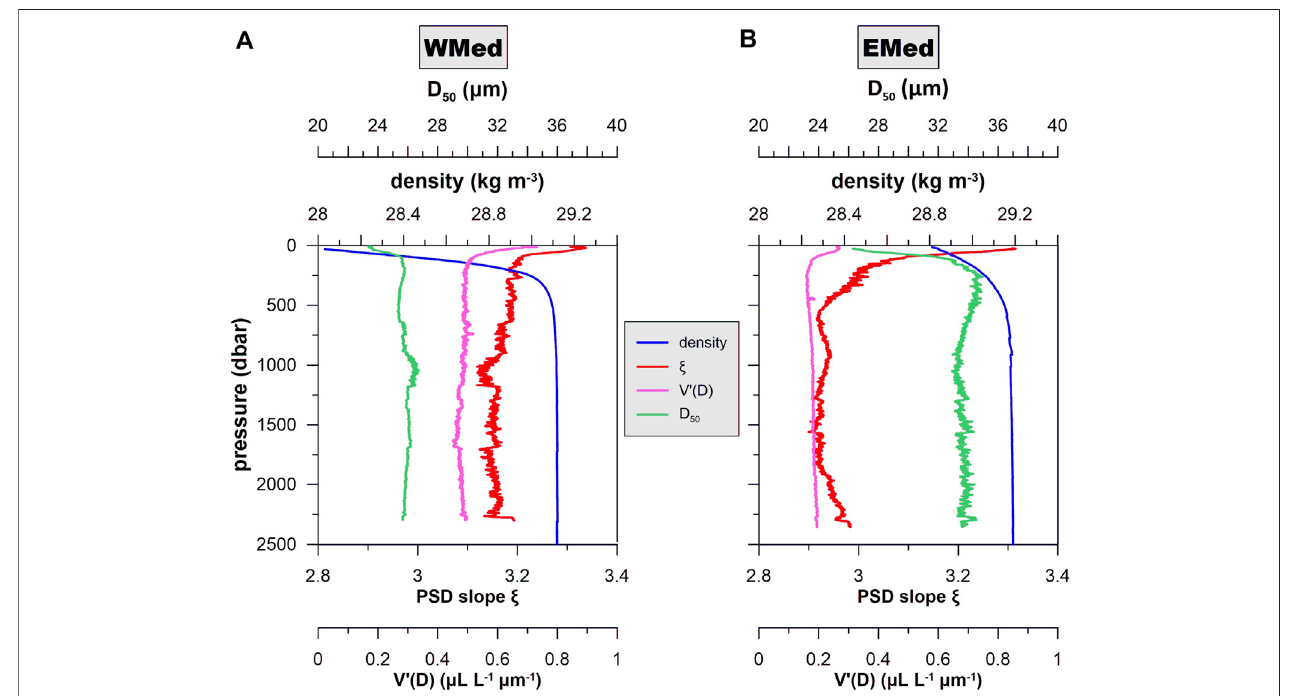
FIGURE 7 | Pro fi les of mean (smoothed by a 10-point moving average) density, V ’ (D), D 50 , and PSD slope ξ for the WMed (A) and EMed (B) . Differential particle volume V ’ (D) in the WMed is almost double in the WMed than in the EMed. Mean ξ in the WMed is overall higher than the EMed demonstrating the presence of larger particle pools below ∼ 500 m in the latter, corresponding at a mean D 50 of ∼ 35 μ